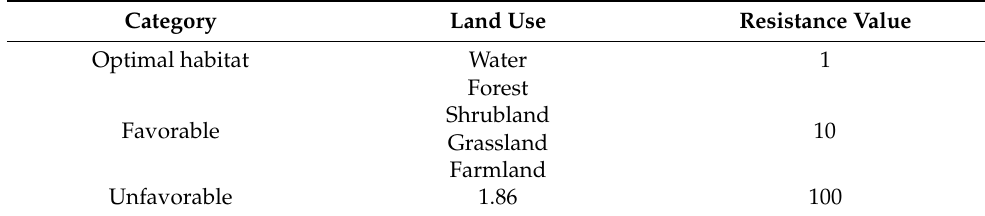
Table 2. List of land use categories and resistance values. Category Land Use Resistance Value Optimal